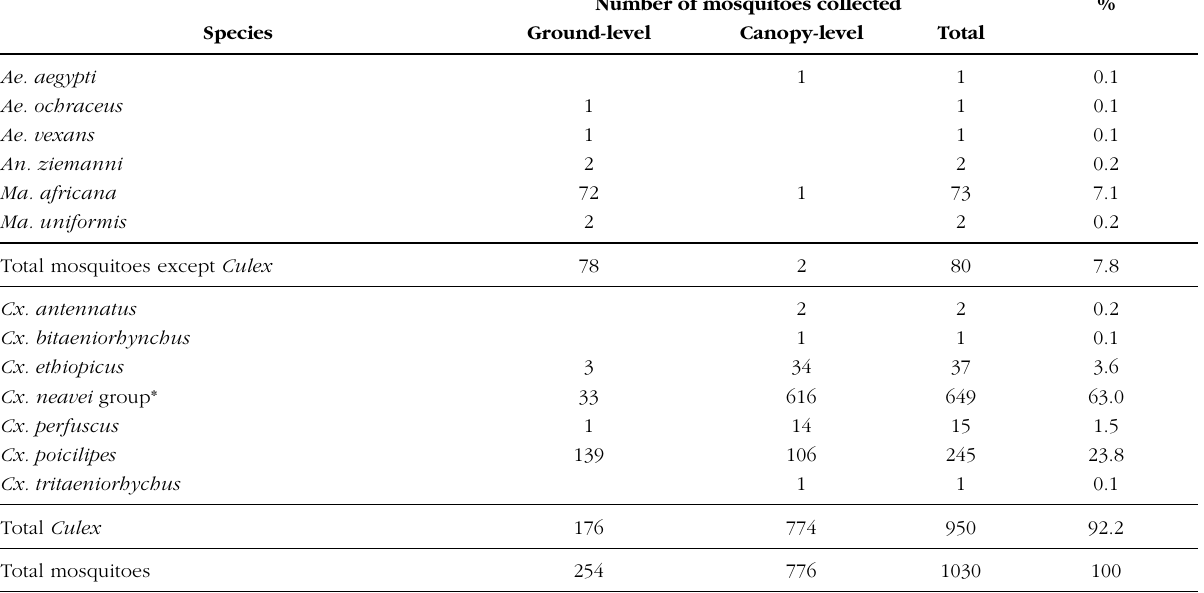
Table i. – Mosquitoes collected by bird-baited traps on the canopy and the ground levels between September 27 and November 26, 2006, at Barkedji, Senegal.